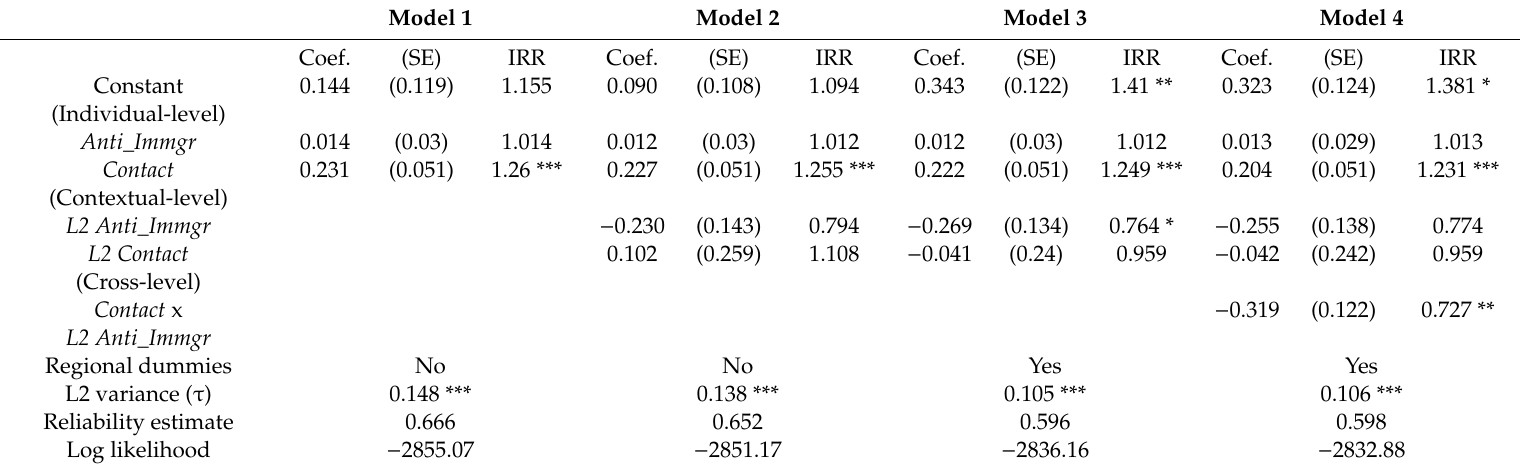
Table 5. Multilevel Poisson Regression Estimates from Predicting Civic